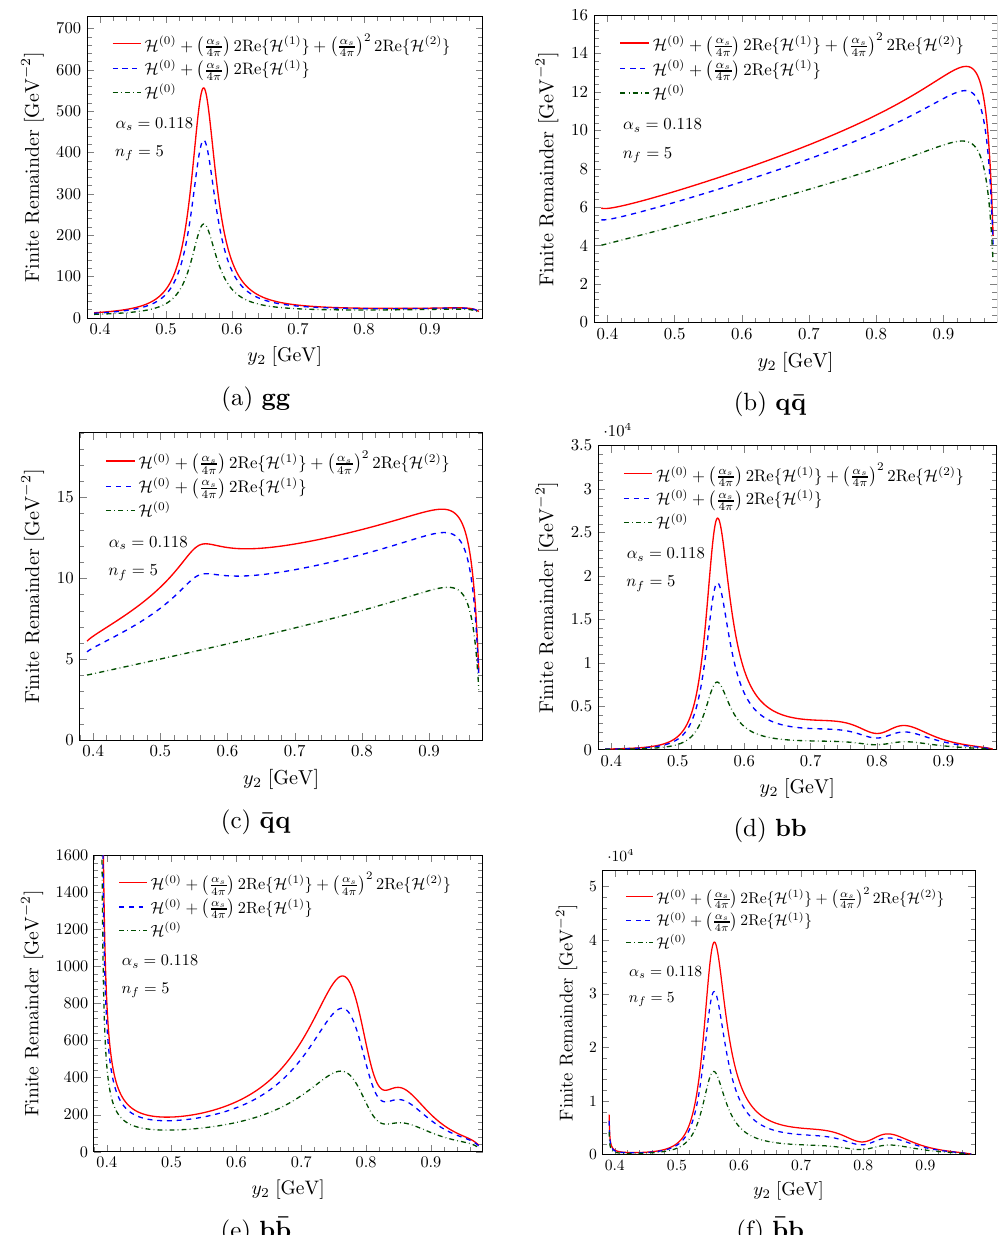
Figure 3. Reduced squared finite remainders H ( L ) at tree level, one and two loops evaluated on the one-dimensional phase space slice defined in eq. (6.12), as functions of the variable y 2 , for the channels defined in eq.